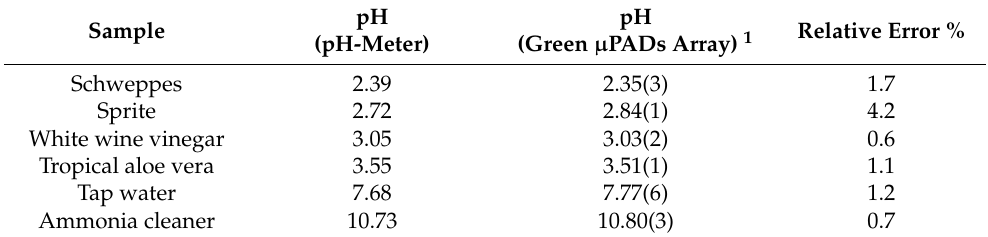
Figure 6. PLS experimental vs. fitted plots for models A (red triangles), B (green triangles) and C (blue triangles). RGB indexes were acquired by the RGB-detector. Table 2. pH values of samples used as a test set for validation of PLS models. Comparison between the values measured by a pH-meter and those obtained by the green µPADs array-PLS models. RGB indexes were acquired with the RGB-detector.